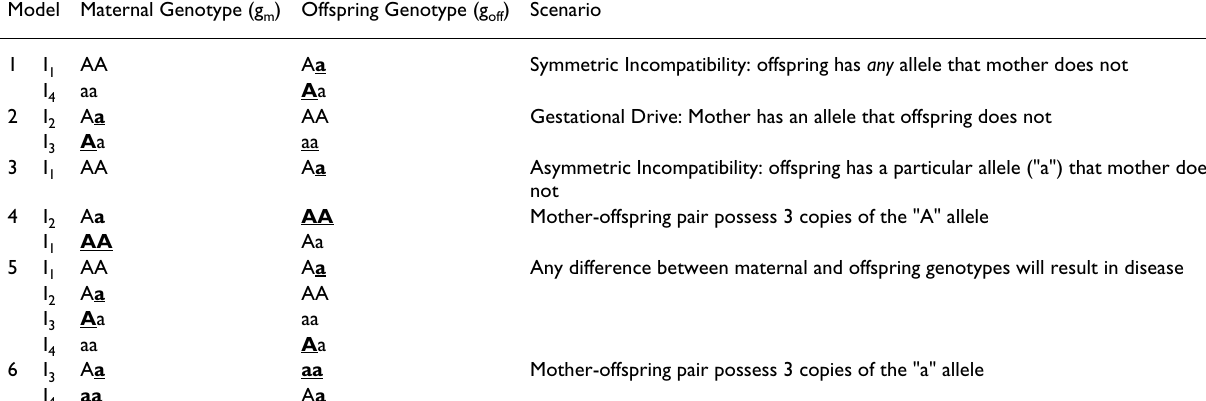
Table 2: Biologically plausible models of incompatibility Model Maternal Genotype (g m ) Offspring Genotype (g off )